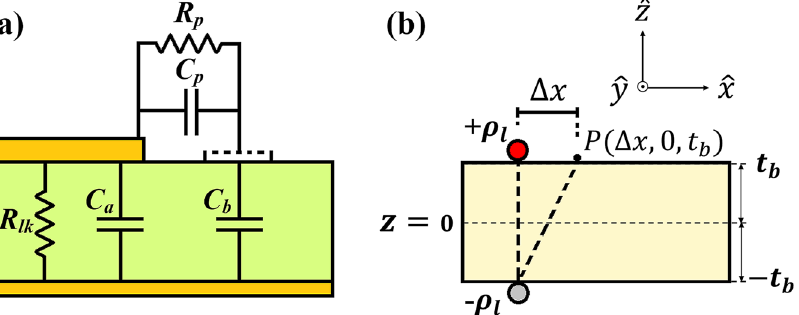
Figure 2. Electrical model of the DBD reactor cross-section. ( a ) Equivalent circuit of each tooth of the comb structure in the DBD reactor. ( b ) Diagram used to calculate the surface potential using method of images.